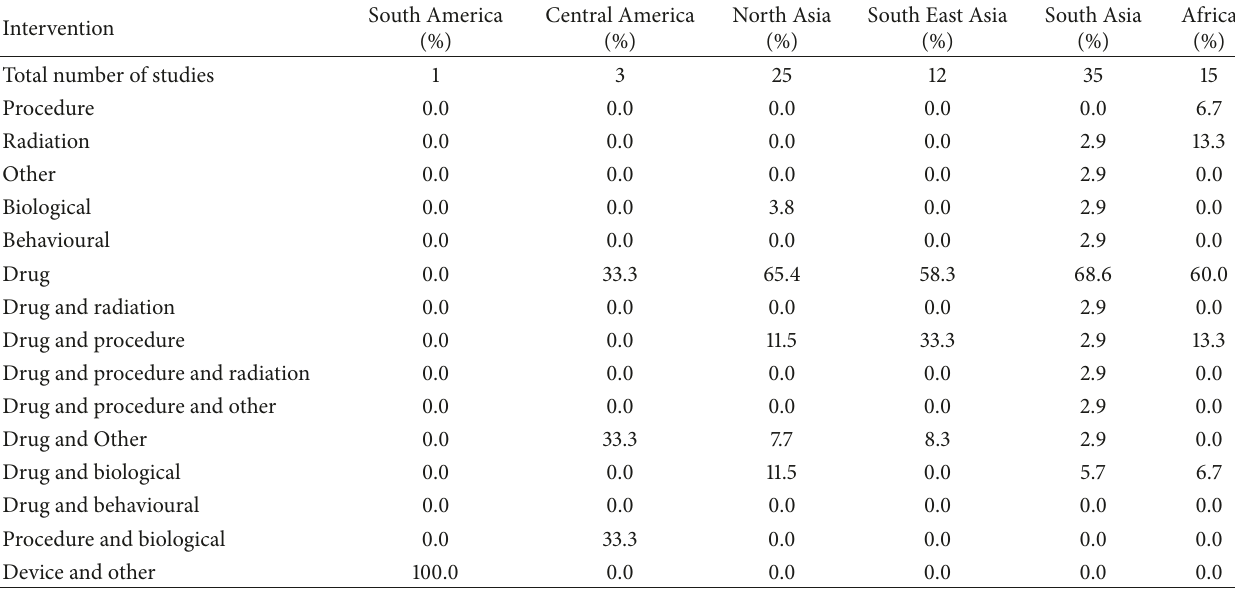
Table 4: Types of intervention for RCTs in breast cancer research in LMICs in each region . The percentage for each intervention was calculated. North America and East Asia are not included due to no LMICs being present in these